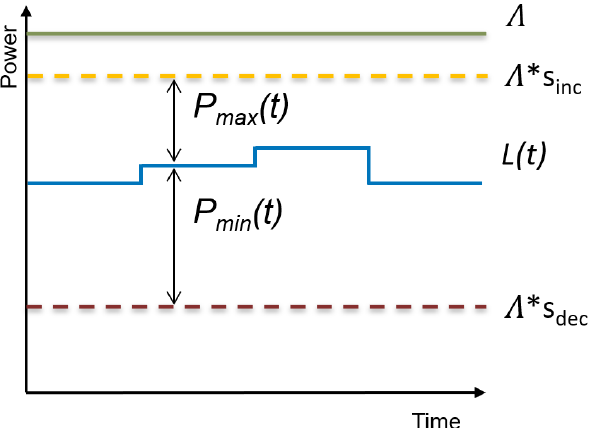
Figure 2. Schematic illustration of the load increase and decrease buffers, P max and P min